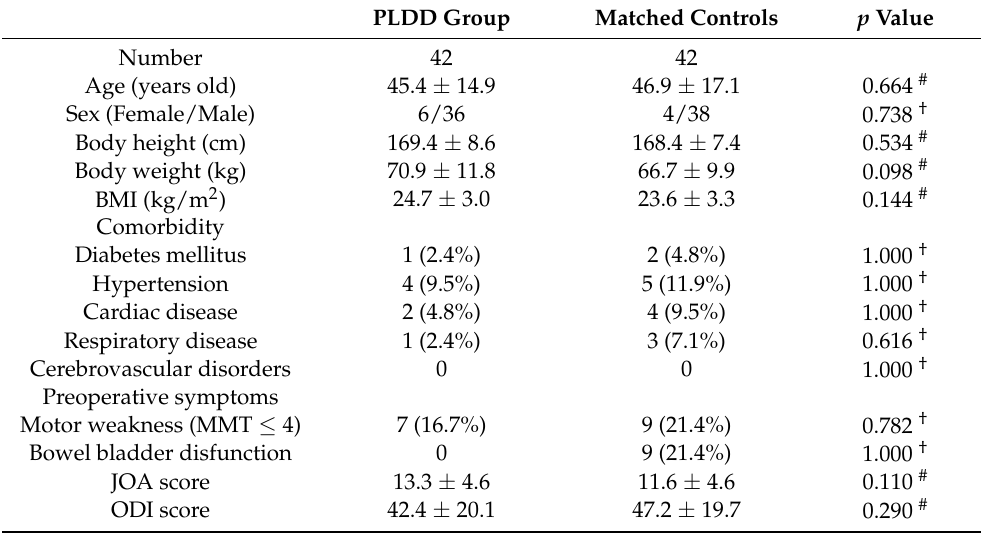
Table 2. Comparisons of preoperative data between the PLDD group and the matched controls.